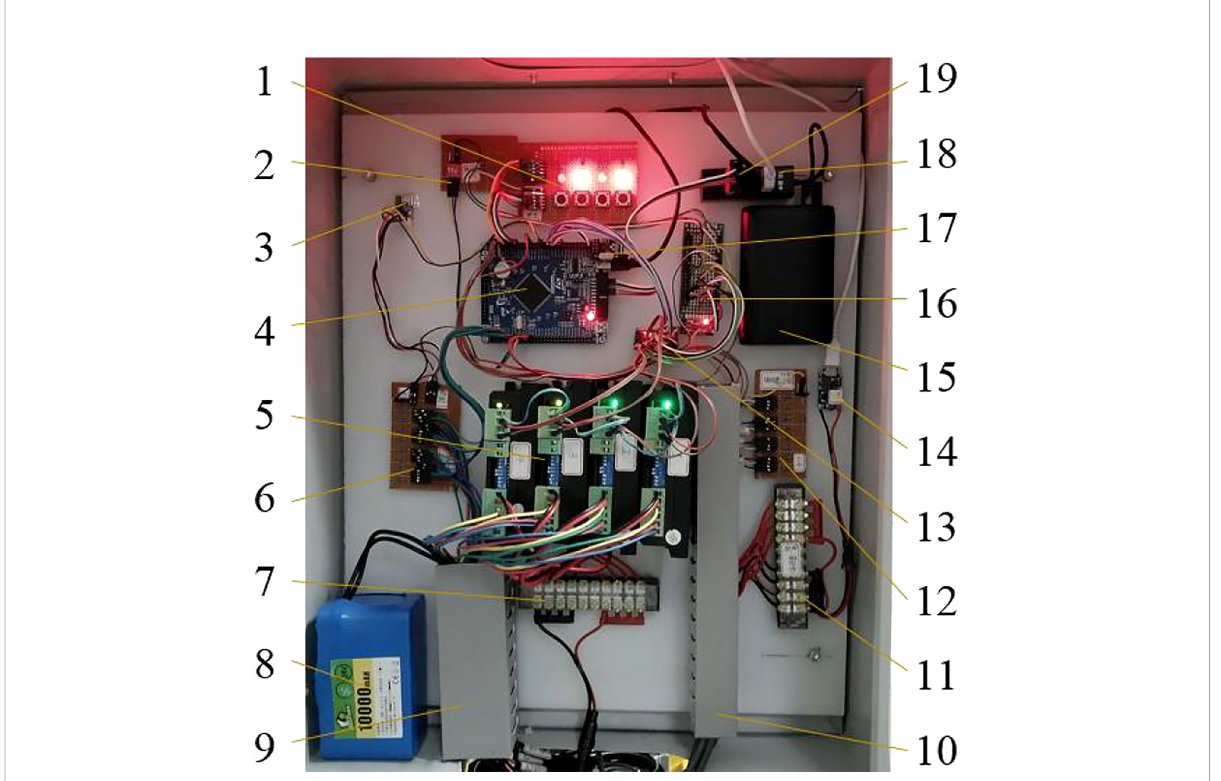
FIGURE 2 Pro fi ling control circuit system offruit tree pro fi le variable sprayer 1. Button LED module 2. DIP switch 3.2.4G wireless serial port module 4. STM32F1 control board 5. Stepper motor drivers 6. Pull-up circuit module one 7. Terminal block one 8.24V power supply 9.4-channel stepper motor lines, limit Bit lines and wire slot 10. Encoder wiring and wire slot 11. Terminal block two 12. Pull-up circuit module two 13. Level conversion board 14. Booster module 15. 5V power supply 16. Power adapter board 17. NRF24L01 Module 18. USB extender 19. ST-LINK V2